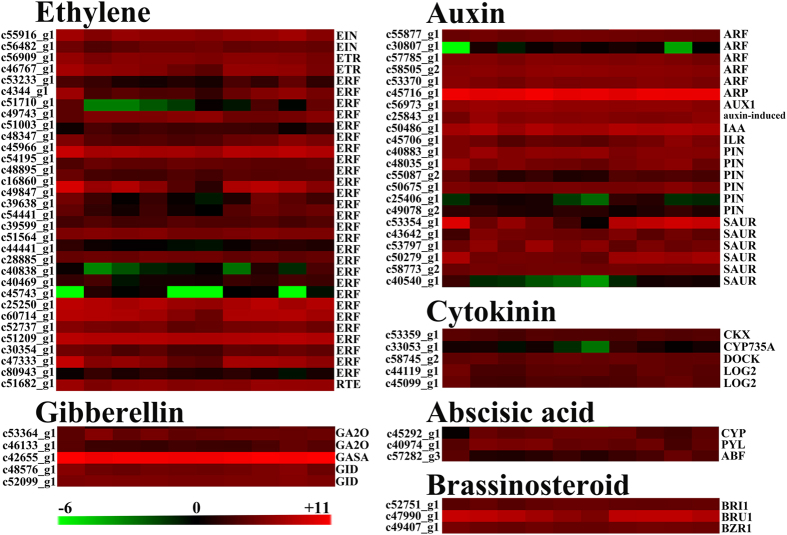
Expression profiles of phytohormone-associated genes in SDM shoots after ethephon treatment.Hierarchical clustering of the expression levels of differentially expressed hormone-associated genes including ethylene, abscisic acid, auxin, gibberellin, brassinosteroid, and cytokinin involved in biosynthesis, degradation and signaling during ETH response.